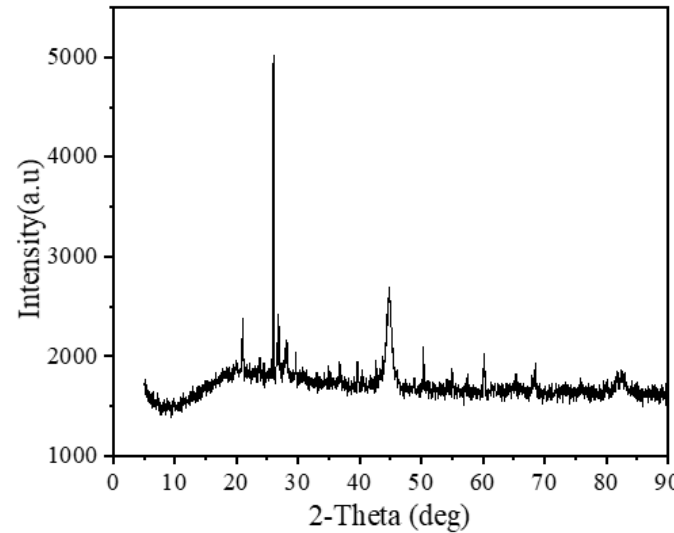
Figure 11. XRD analysis of the reaction between NICLS and phosphorus.